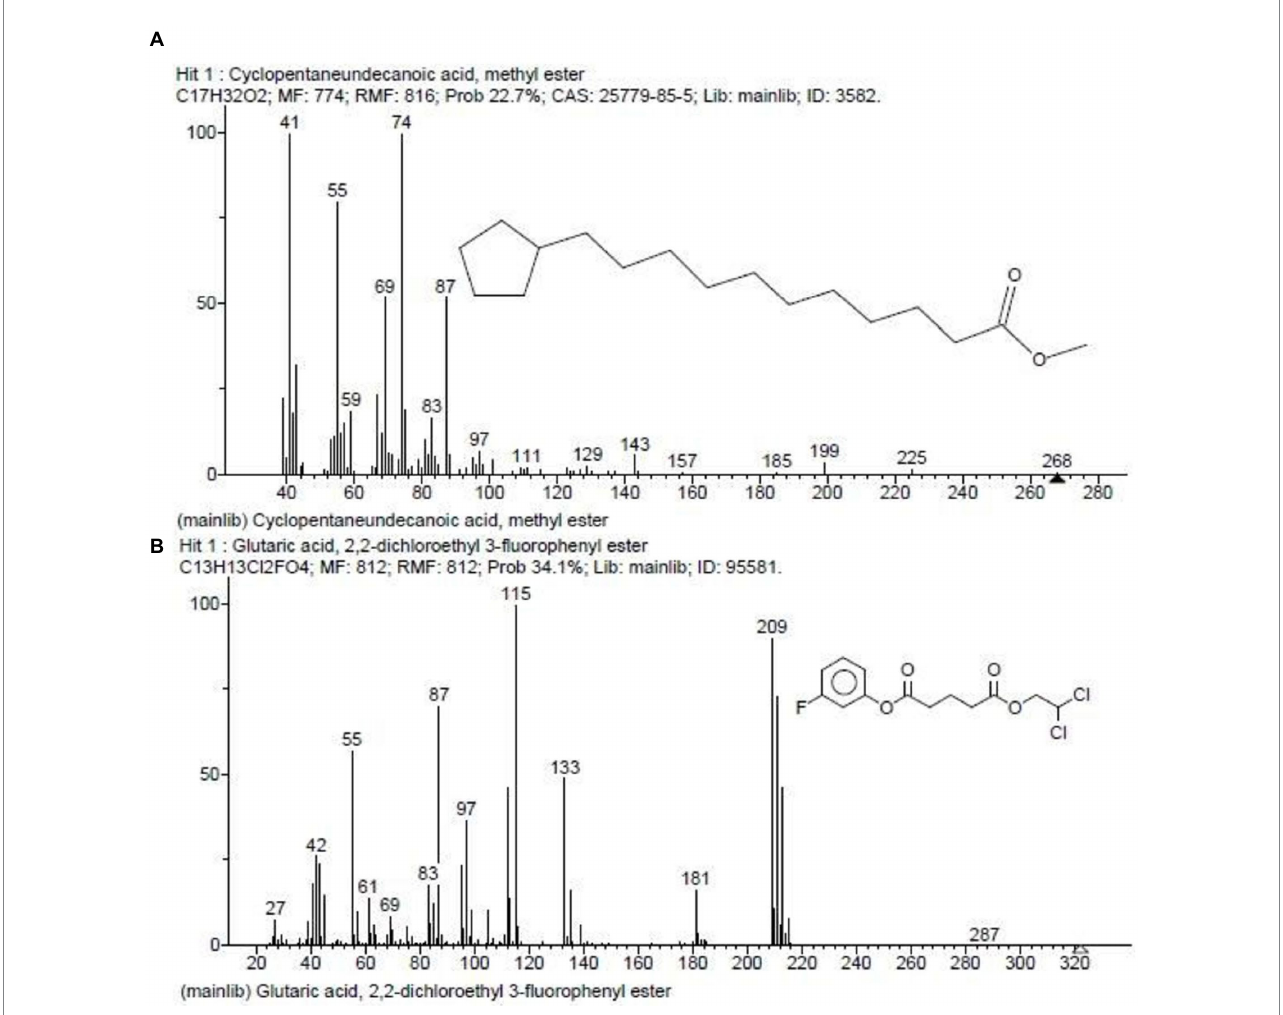
FIGURE 4 GCMS depicted highest probable compounds. (A) Cyclopentaneundecanoic acid, methyl ester 22.7%. (B) Glutaric acid, 2,2-dichloroethyl 3-fluorophenyl ester 34%